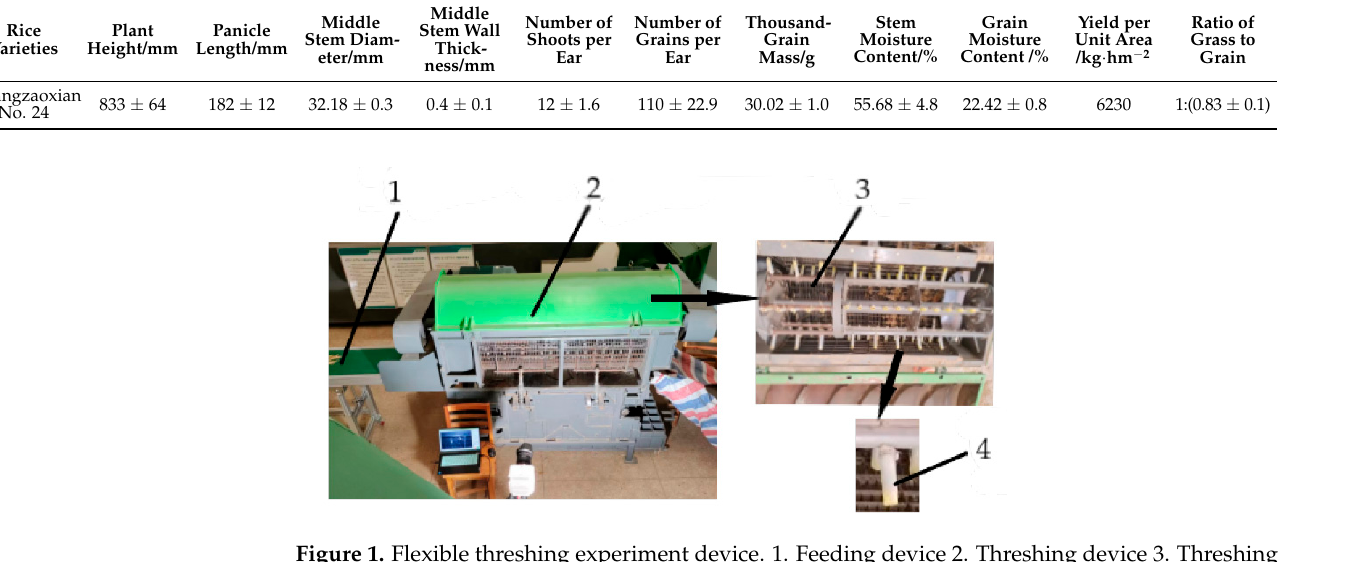
Figure 1. Flexible threshing experiment device. 1. Feeding device 2. Threshing device 3. Threshing cylinder 4. Flexible threshing teeth.